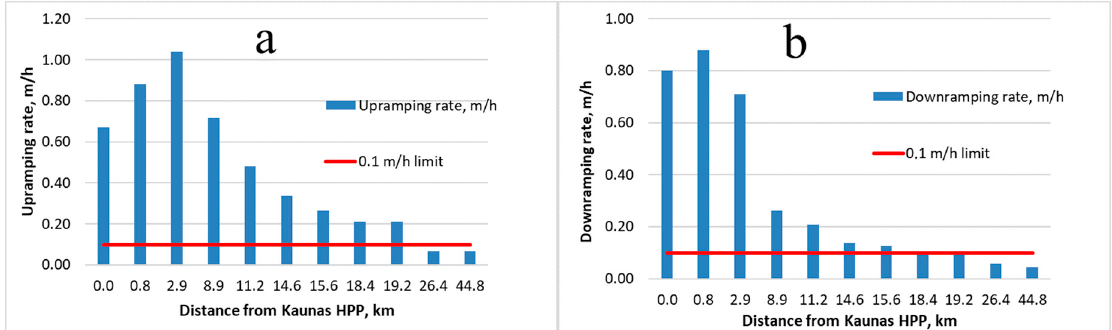
Figure 9. Dynamics of stage fluctuations downstream from Kaunas HPP during a low flow period: ( a ) upramping; ( b ) downramping. Red line: stage fluctuation limit assigned for natural flowing rivers (0.1 m/h).